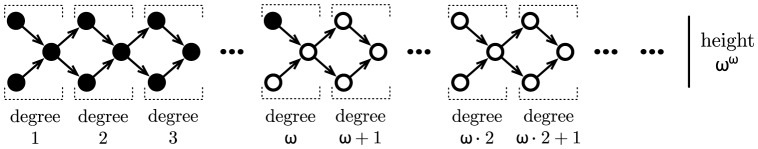
Comparison between the RNN and the complete RNN hierarchies.The RNN hierarchy, depicted by the sequence of blacks classes, consists of an initial segment of length  of the complete RNN hierarchy, which has height .